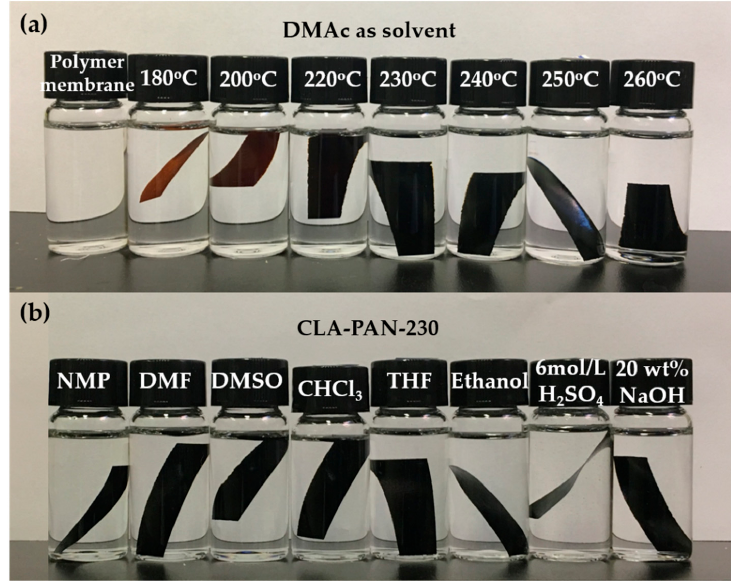
Figure 12. Solubility of PAN and CLA-PAN membranes prepared at different cross-linking temperatures in N-Dimethylacetamide (DMAc) ( a ); solubility of CLA-PAN-230 membrane in common solvents ( b ).